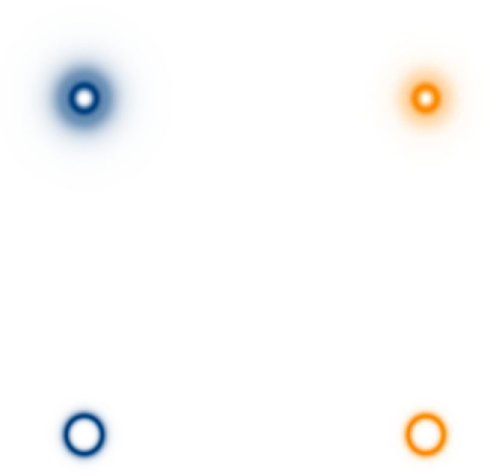
Fig. 3 The radial component of the electric field (left, blue) with e = 1 andtheenergydensity(right,orange)associatedtothemodelinSect.3.1 depicted in the plane for σ = 5, with k = 1 (top), and k = 2 (bottom). The intensityof the blue and orange colors increases withthe increasing of the electric field and energy density,